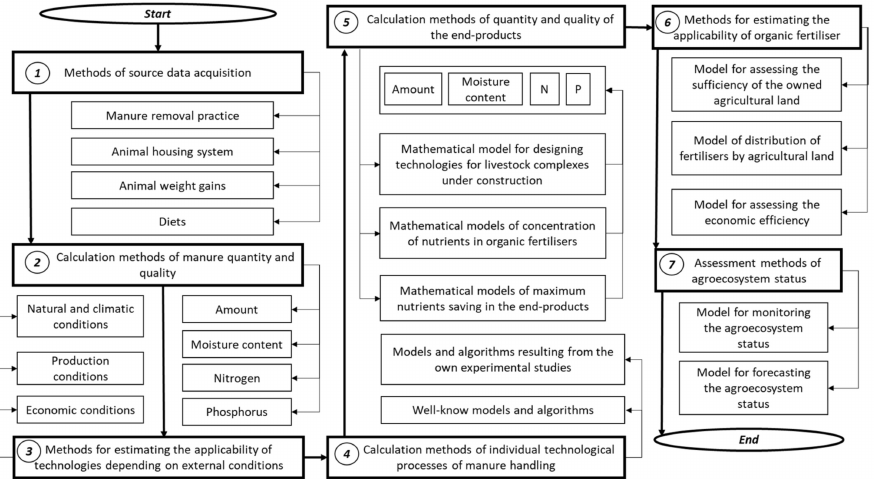
Figure 4. General methodological approach to designing the technologies for the end-product production.